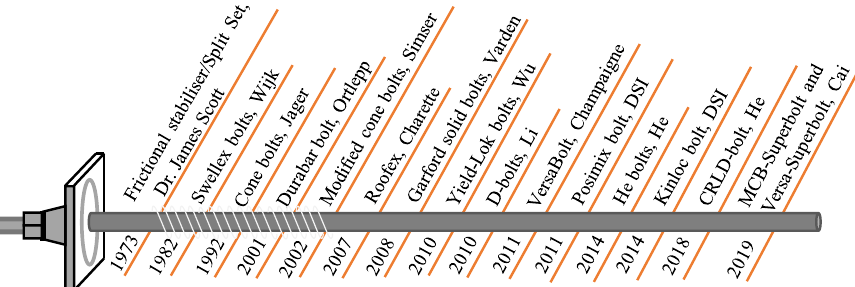
Figure 14. Typical energy-absorbing bolts [60,192,201–207].